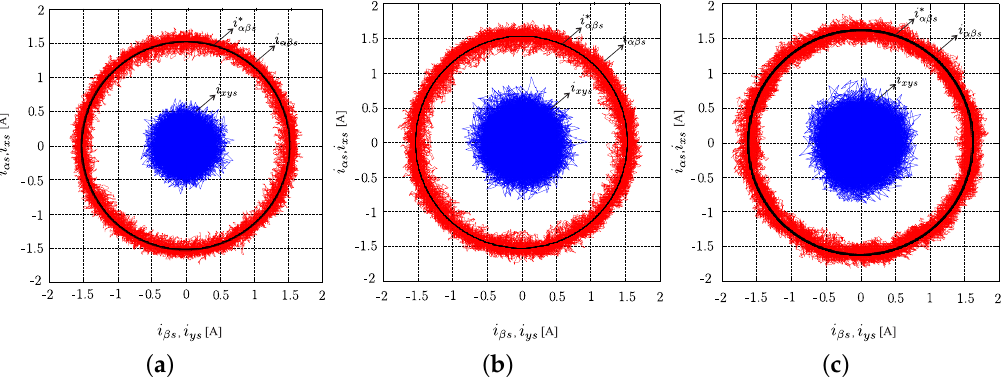
Figure 5. Simulation performance in steady-state condition of stator currents in ( α - β ) and ( x - y ) sub-spaces for a sampling frequency of 8 kHz at different speeds ( ω m ): ( a ) 500 rpm; ( b ) 1000 rpm; ( c ) 1500